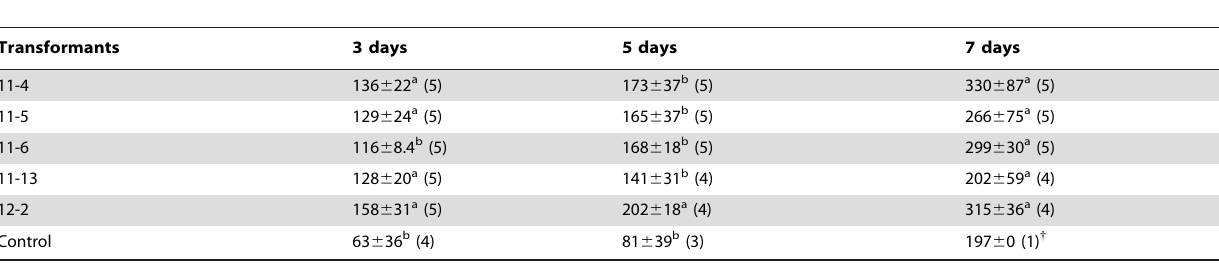
Table 4. Weights of black cutworm feeding on leaves from N. benthamiana BvSTI T2 homozygous plants.